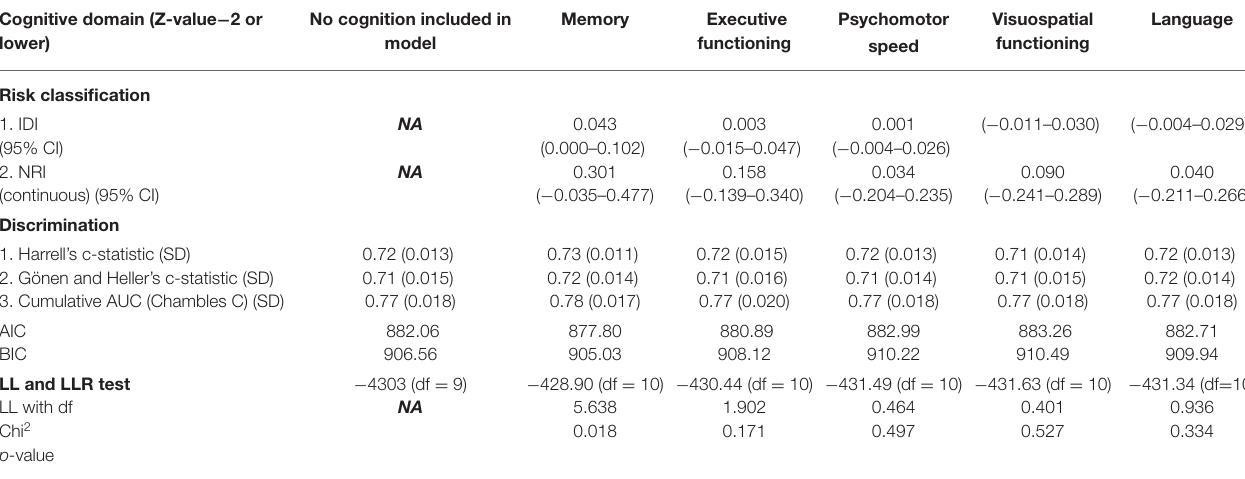
TABLE 3 | Mean added prognostic value for each cognitive domain in high-grade glioma. Cognitive domain (Z-value − 2 or